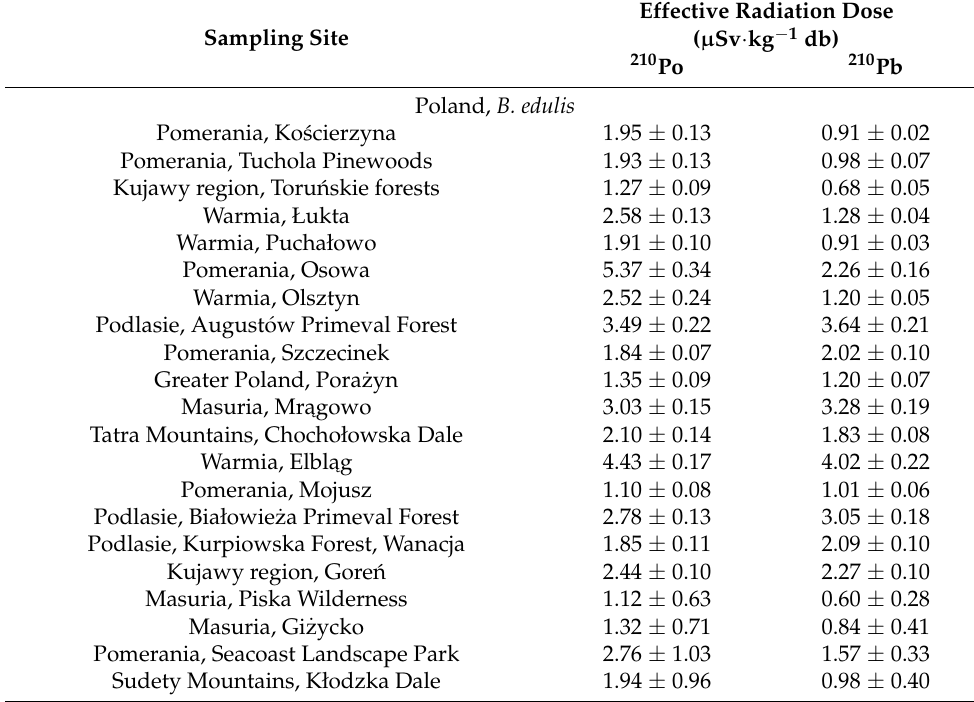
Table 3. Calculated average values of the effective radiation dose for adults from 210 Po and 210 Pb decay through Boletus spp.